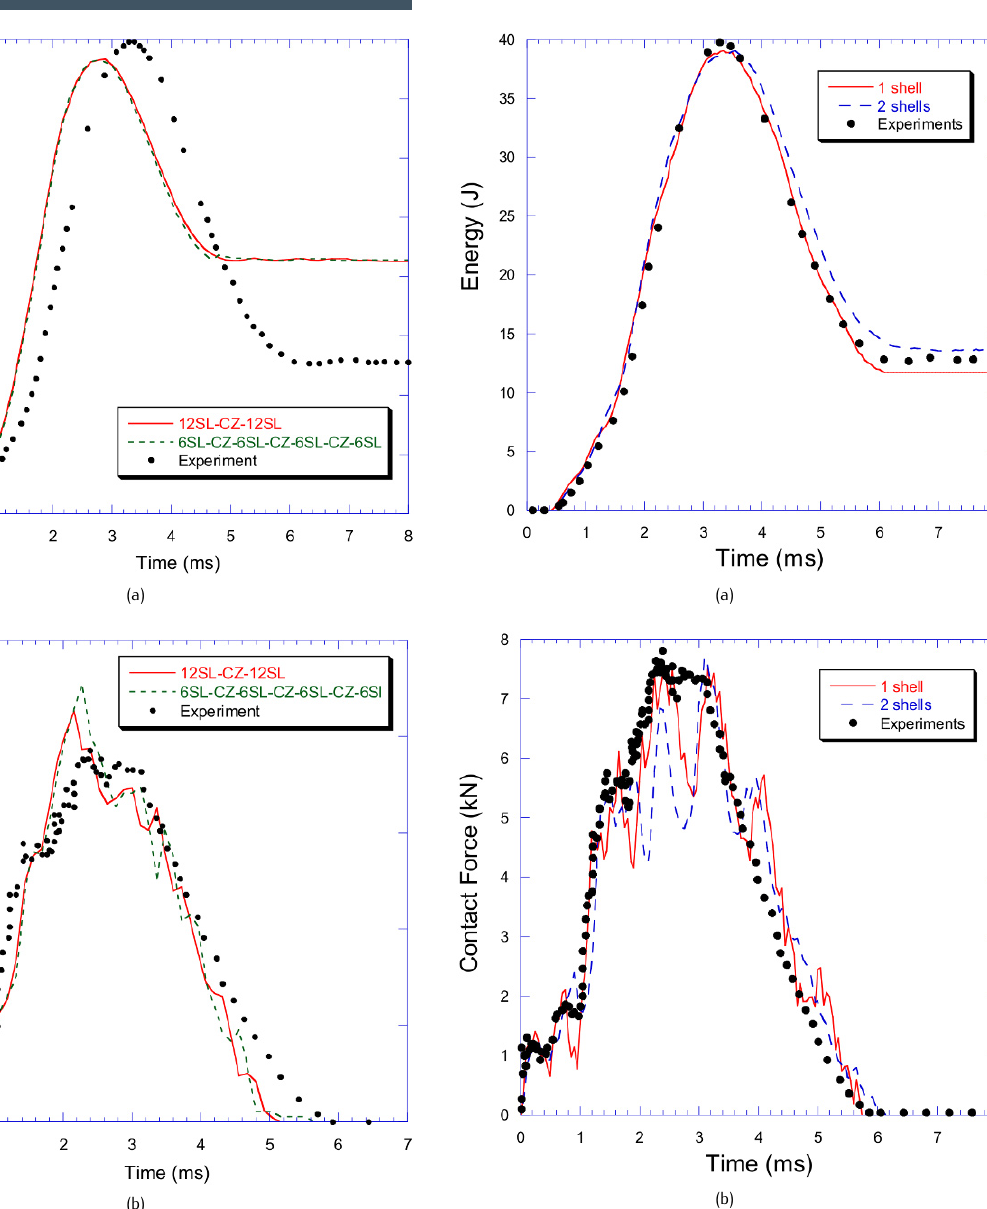
Figure 8. Internal Energy and Contact Force for impact analysis with using thin shell (SHELL163) and Tiebreak contacts. Experiment from